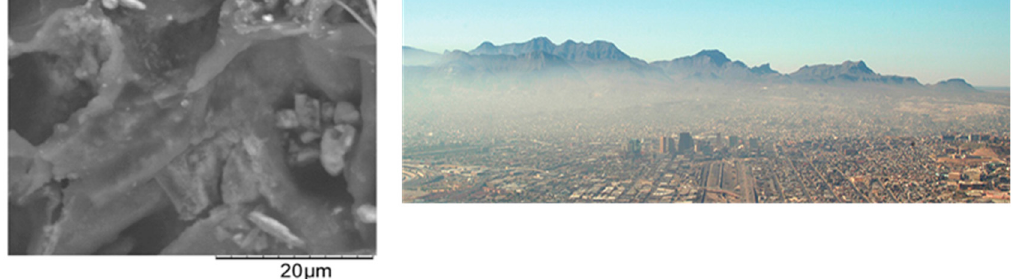
Figure 1. ( Left) Scanning electron microscopy image of particulate aerosols, which are among the most common on the region, particle size can range from nanometers to microns. ( Right ) Panoramic photograph on a high-polluted day at El Paso-Juárez region, one can observe a clear a dusty cloud suspended at the atmosphere (Image credit: https://www.quora.com/ [What is the air pollution like in El Paso, TX?]).